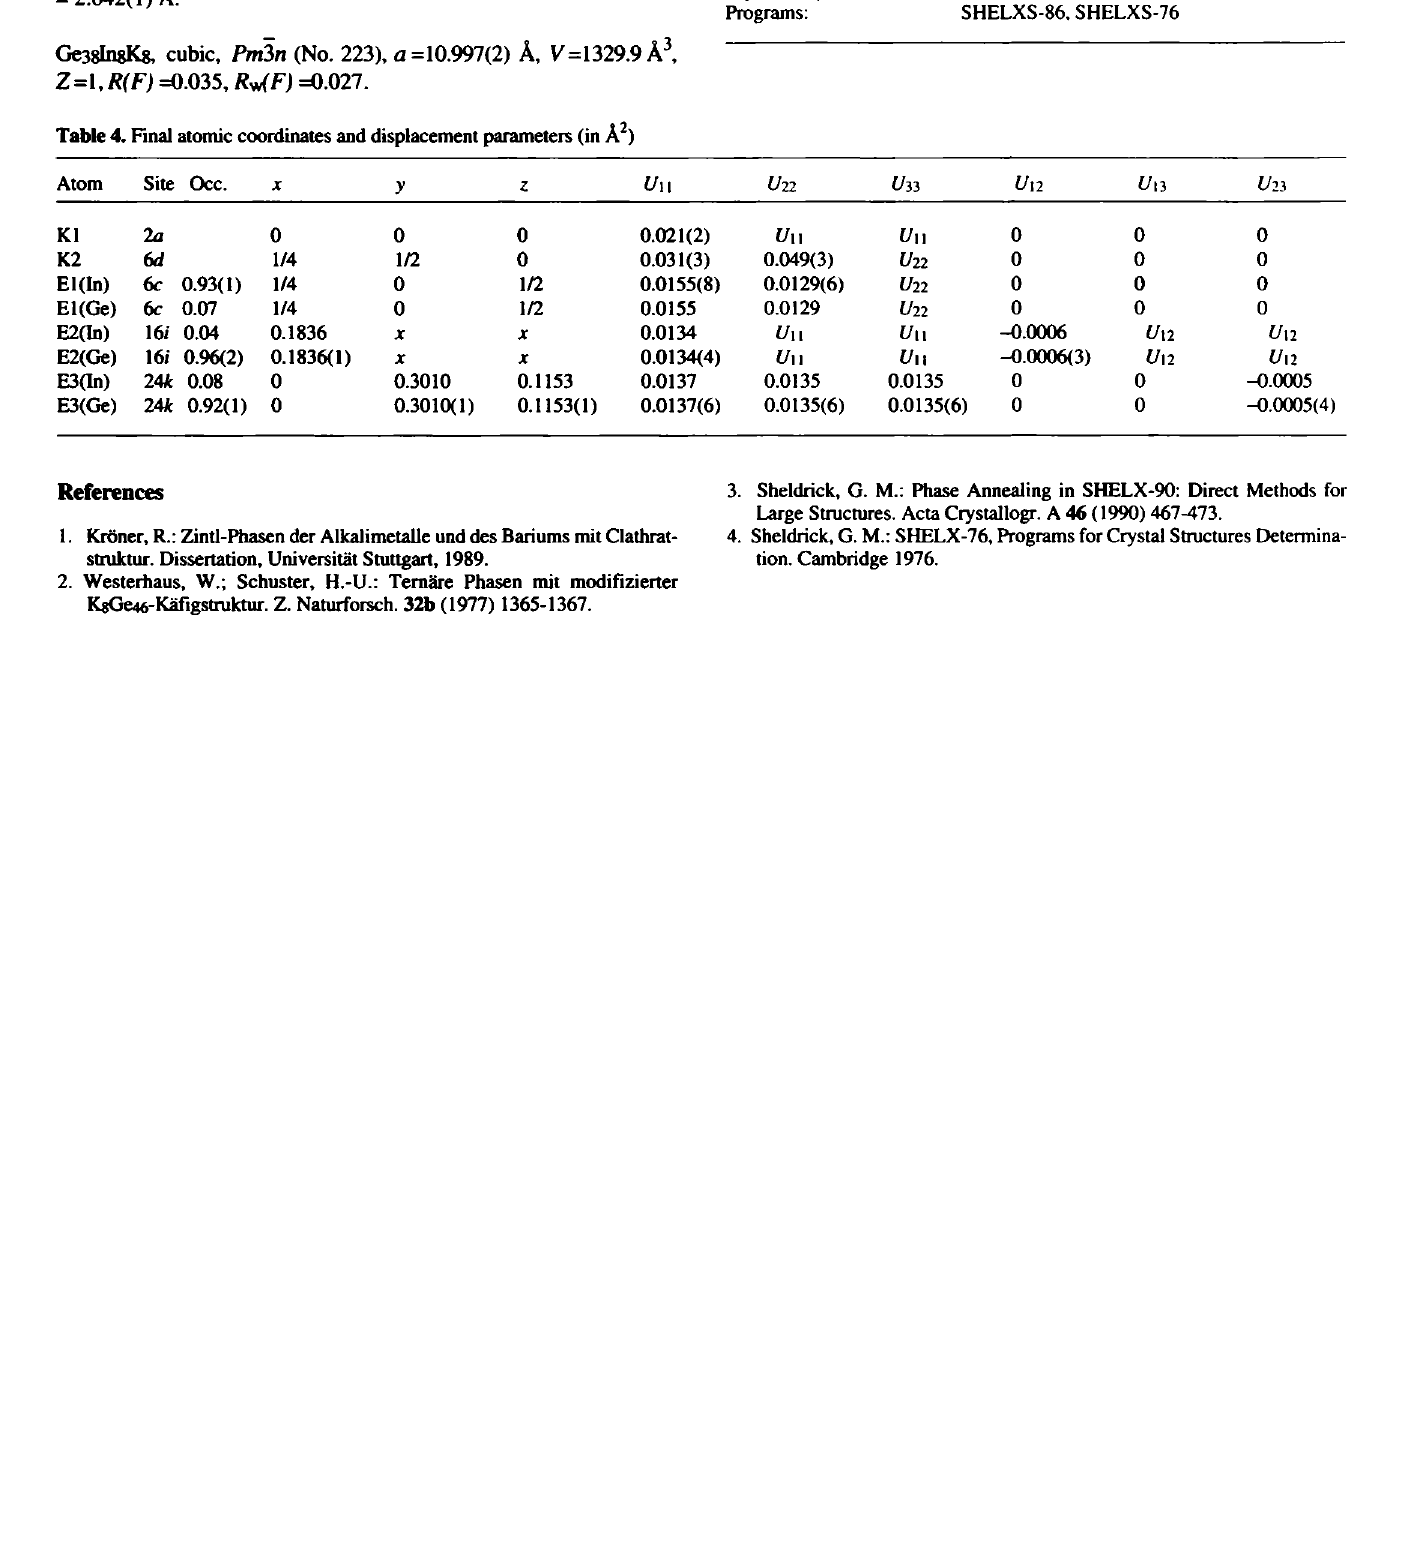
Table 4. Final atomic coordinates and displacement parameteis (in Â^)